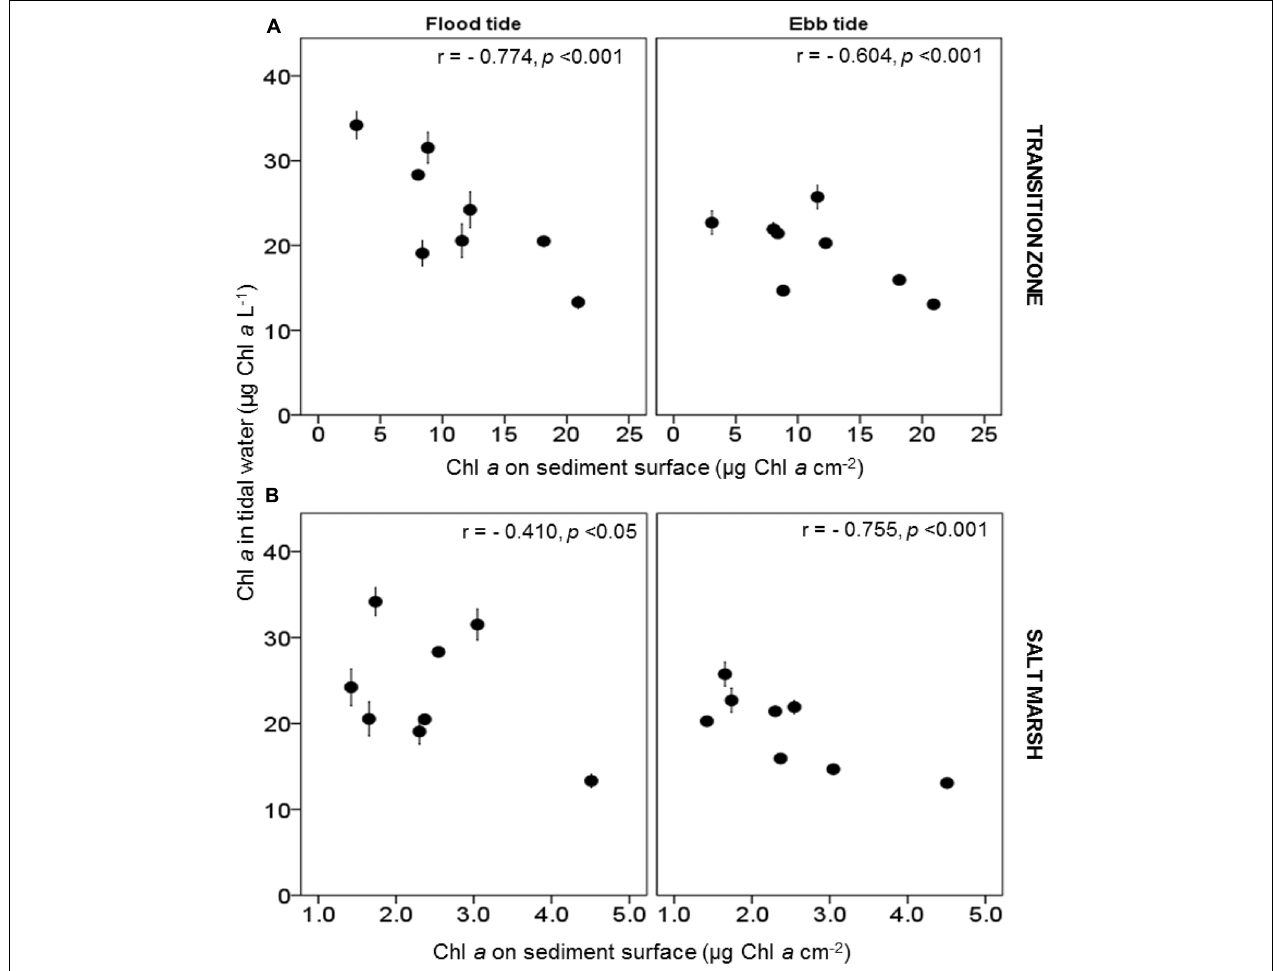
FIGURE 5 | Relationship between Chl. a concentration ( µ g L − 1 ) in flood and ebb-tide water (mean values ± SE, n = 3) with the Chl. a concentration in the top 2 mm per cm 2 sediment surface of the (A) transition zone of the mudflat and; (B) salt marsh at Fingringhoe Wick, Colne Estuary, Essex, United Kingdom, in August and September 2015. Pearson’s correlation coefficients (r) on daily mean of flood and ebb data.